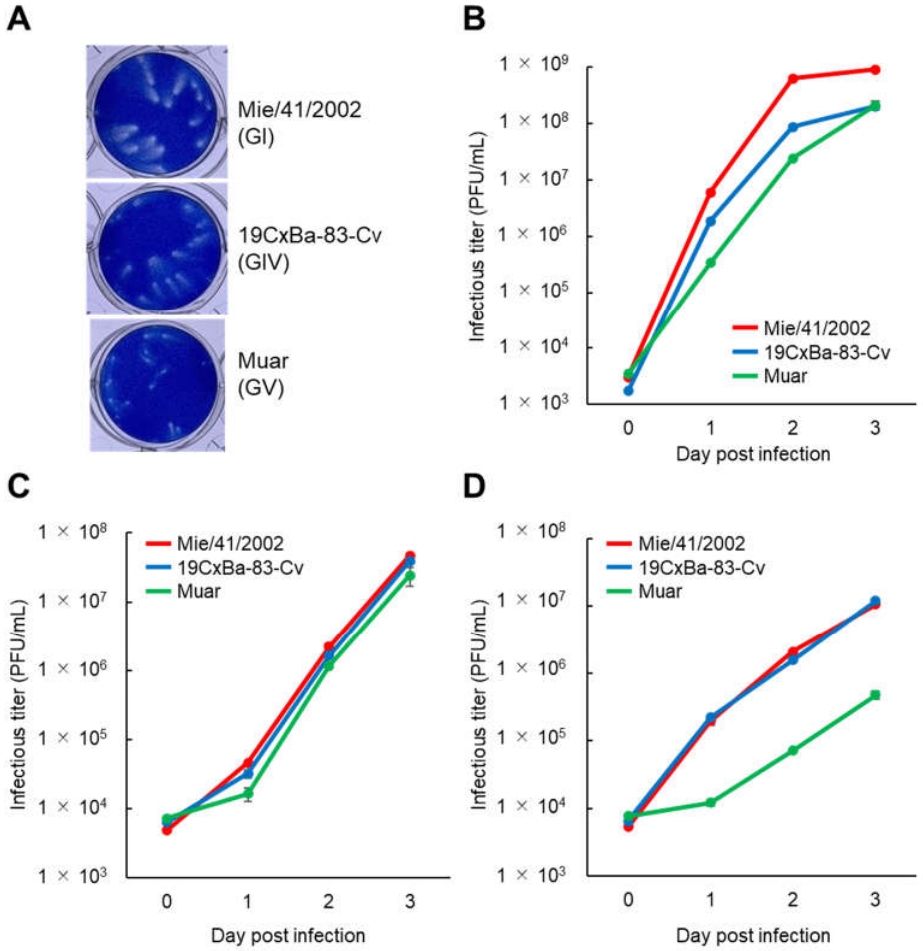
Figure 2. Growth properties of the GI, GIV, and GV JEV strains. ( A ) Plaque phenotypes of GI Mie/41/2002, GIV 19CxBa-83-Cv, and GV Muar in Vero cells. ( B – D ) Growth curves were measured for Mie/41/2002, 19CxBa-83-Cv, and Muar in Vero ( B ), IMR-32 ( C ), and Neuro-2a ( D ). Cells were plated into 6-well culture plates and infected with the viruses at a multiplicity of infection (MOI) of 0.02 (Vero) or 0.1 (IMR-32, Neuro-2a) plaque forming units (PFU)/cell. Values: means ± standard deviation from three independent